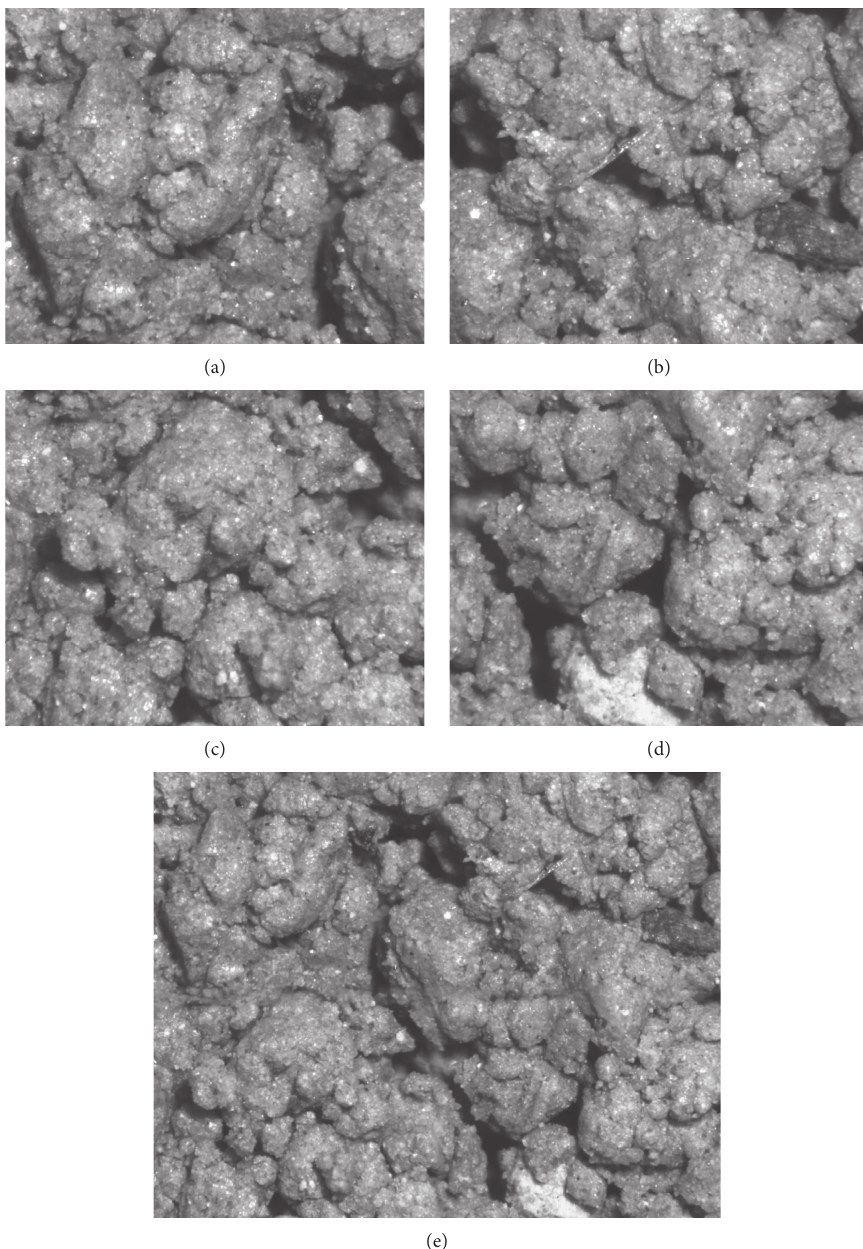
Figure 8: Image mosaic